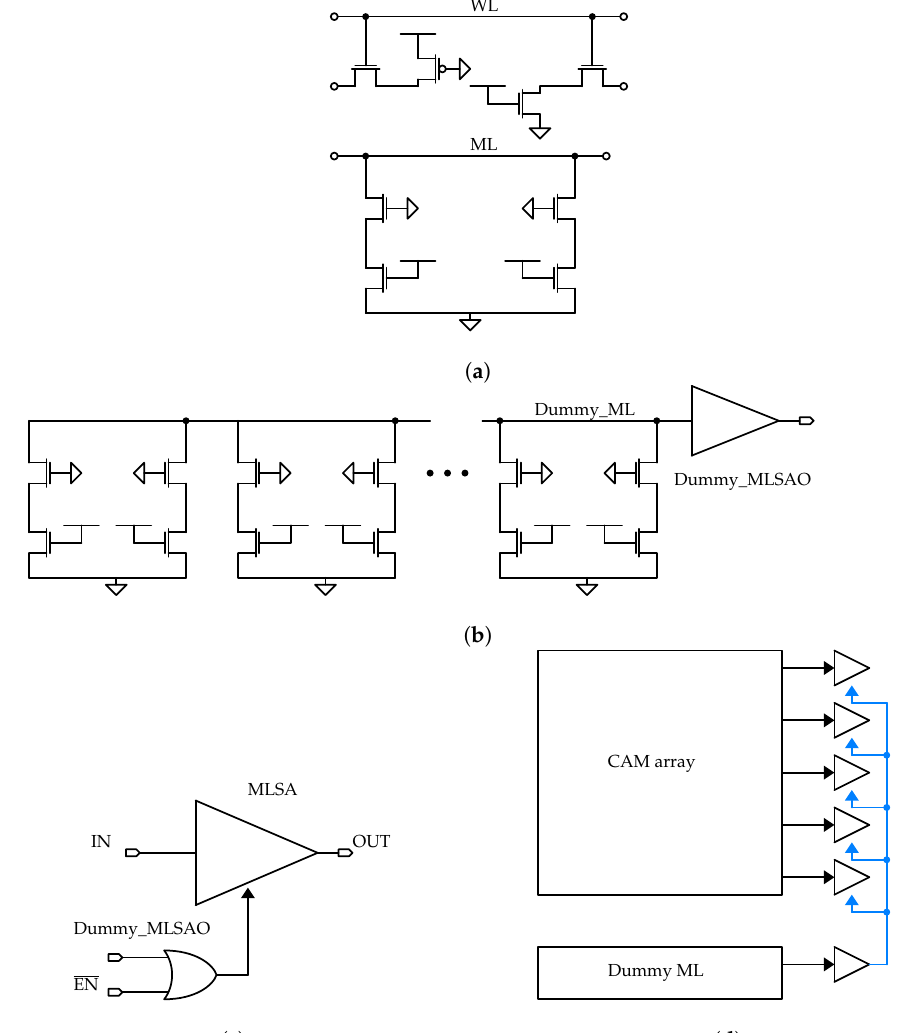
Figure 3. The dummy matchline scheme. A dummy MLSA is used to disable the current sources of the real MLSAs to save power during a search operation. ( a ) The dummy cell of the CAM. Only the matchline and wordline transistors are kept in the circuit, together with a dummy SRAM core that stores a logic ‘1’. ( b ) The dummy matchline. The dummy cells are arranged in a matchline of length equal to the memory width one, and that is connected to a dummy MLSA. Part of the dummy CAM cell is omitted for the sake of clarity. ( c ) The output of the dummy MLSA is used to disable the other MLSAs: as soon as the dummy MLSA output changes, it means that the time needed for the match sensing has passed, and the current sources of the real MLSAs can be disabled. In order to achieve this, an OR gate is added inside each MLSA, and its output is used as internal enable signal. ( d ) The output of the dummy MLSA is connected to all the other MLSAs. The position of the dummy matchline is critical: since the dummy MLSA determines the timing of the memory, the line position has to be associated to the worst case for the sensing